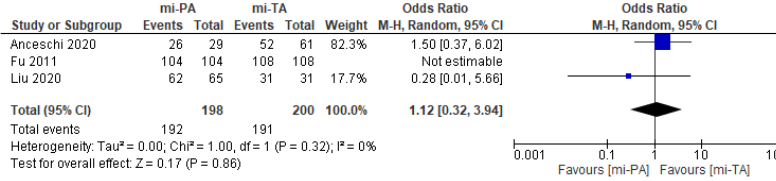
( i ) Forest plot representing analysis of patients with postoperative persistent hypokalemia.